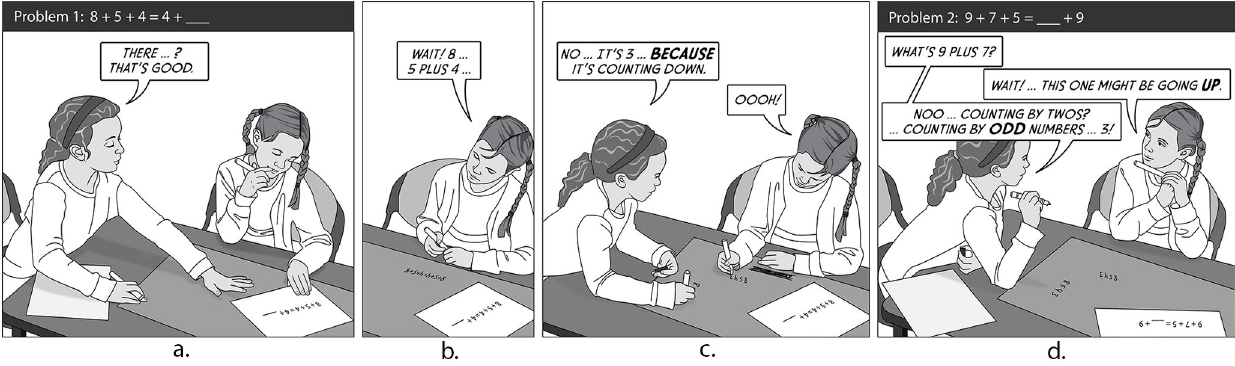
Figure 1. Synoptic comic strip of Elsa (left) and Morgan (right) working on Problems 1 and 2. From Alibali, Gutiérrez, & Brown (2017), under a CC-BY4.0